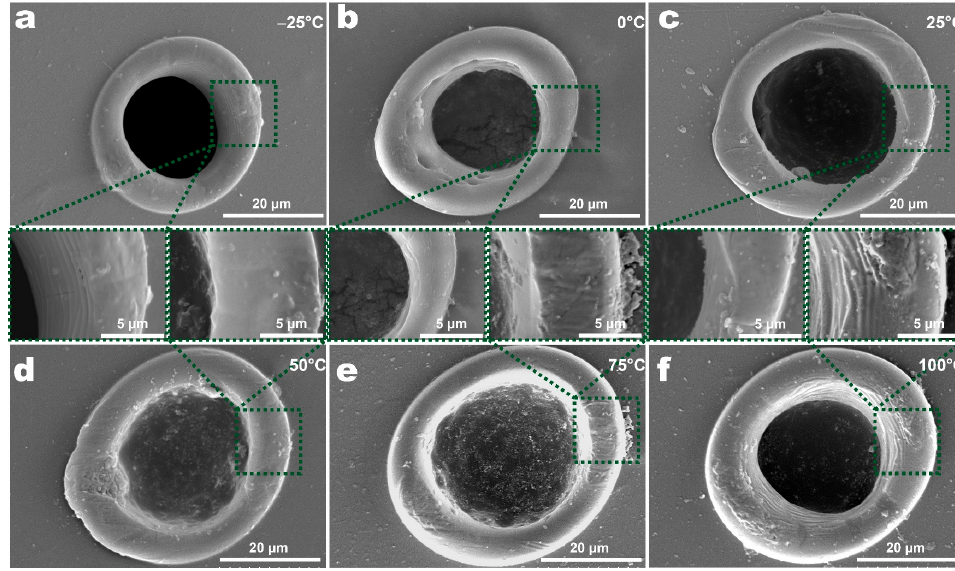
Figure 8. SEM images of holes of PET films at different ambient temperatures in the single-spot laser processing experiment: ( a ) − 25 °C, ( b ) 0 °C, ( c ) 25 °C, ( d ) 50 °C, ( e ) 75 °C, ( f ) 100 °C.